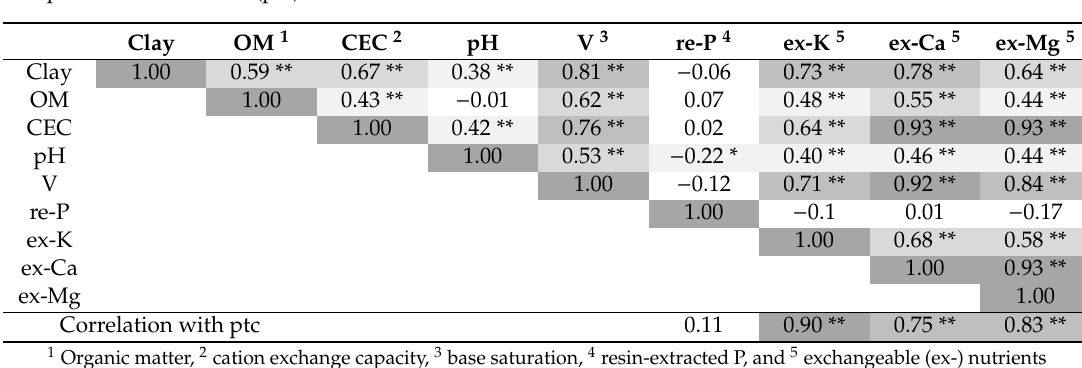
Table 2. Correlation matrix of the studied soil fertility attributes. Correlations between extractable and pseudo total content (ptc) for the di ff erent macronutrients are also shown.